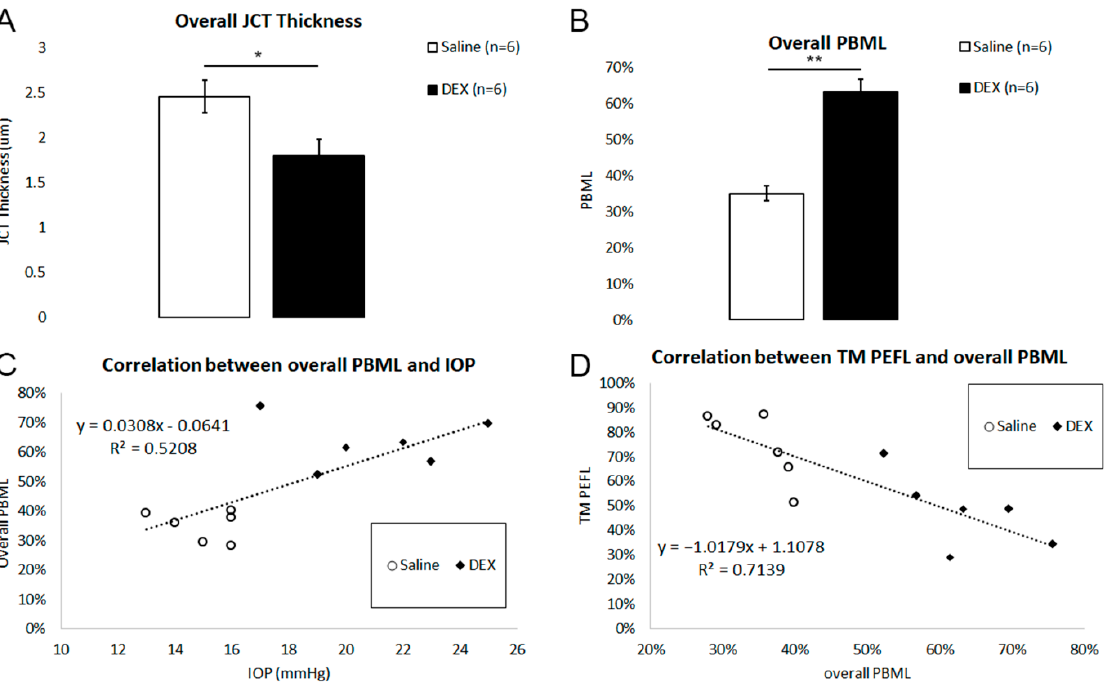
Figure 9. Overall JCT Thickness and Overall PBML. ( A ) The overall juxtacanalicular tissue (JCT) thickness was significantly decreased in dexamethasone (DEX)-treated eyes when compared to con- trols (*: p < 0.05). ( B ) Mean overall percentage basement membrane length (PBML) was significantly increased in DEX-treated eyes when compared to controls (**: p < 0.01). ( C ) There was a significant positive correlation between IOP and overall PBML ( R 2 = 0.52, p = 0.008). ( D ) There was a significant negative correlation between TM PEFL and overall PBML ( R 2 = 0.71, p = 0.0005).